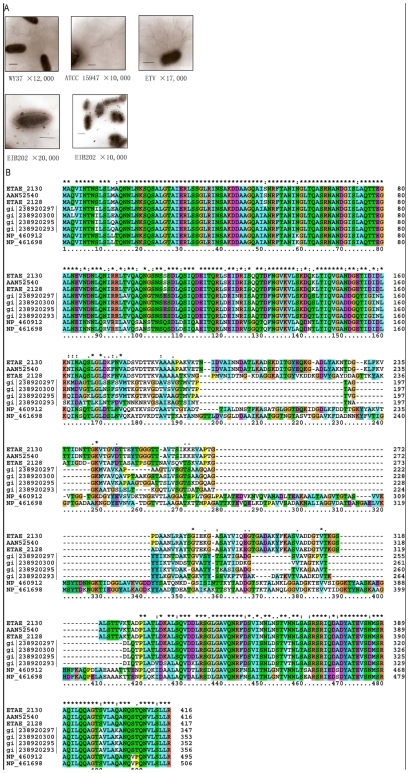
Flagella and flagellin genes of Edwardsiella strains.A. E. tarda strains WY37 (isolated from turbot), ATCC15947 (isolated from human feces) and ETV (isolated from human) were overnight cultured on LB liquid medium. Cells were collected by centrifugation at 1,000 rpm for 2 min following removing supernatant and then fixed with 2.5% glutaraldehyde. Scale bars represent 1 µm. B. The aligned putative flagellin sequences from E. tarda EIB202 (ETAE_2128, ETAE_2130), E. tarda PPD130/91 (AAN52540), E. ictaluri str. 93-146 (gi|238920295|, gi|238920297|, gi|238920300|) and S. typhimurium LT2 (NP_461698, NP_460912). Protein sequences are typically highly conserved at their C-terminal and N-terminal ends encoding the flagellar filament backbone while the middle region is generally quite variable, representing the surface-exposed and antigenically variable portion of the filament.